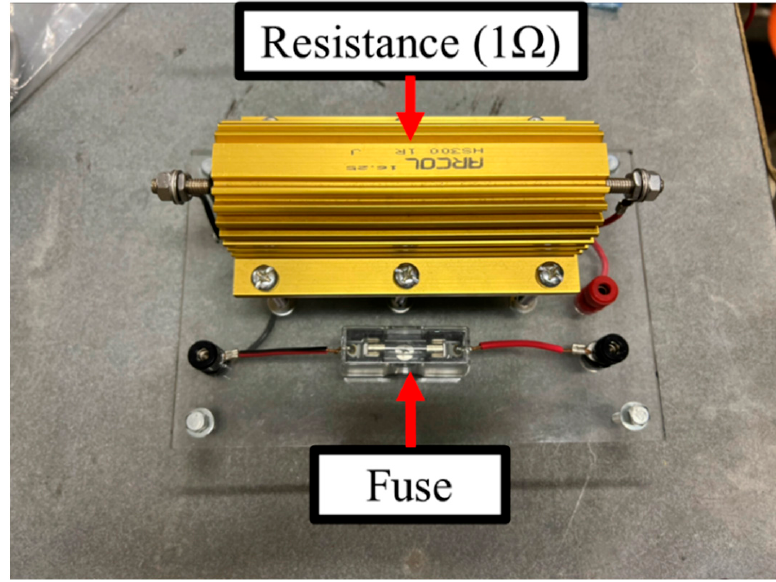
Figure 9. Photograph of the resistance part.